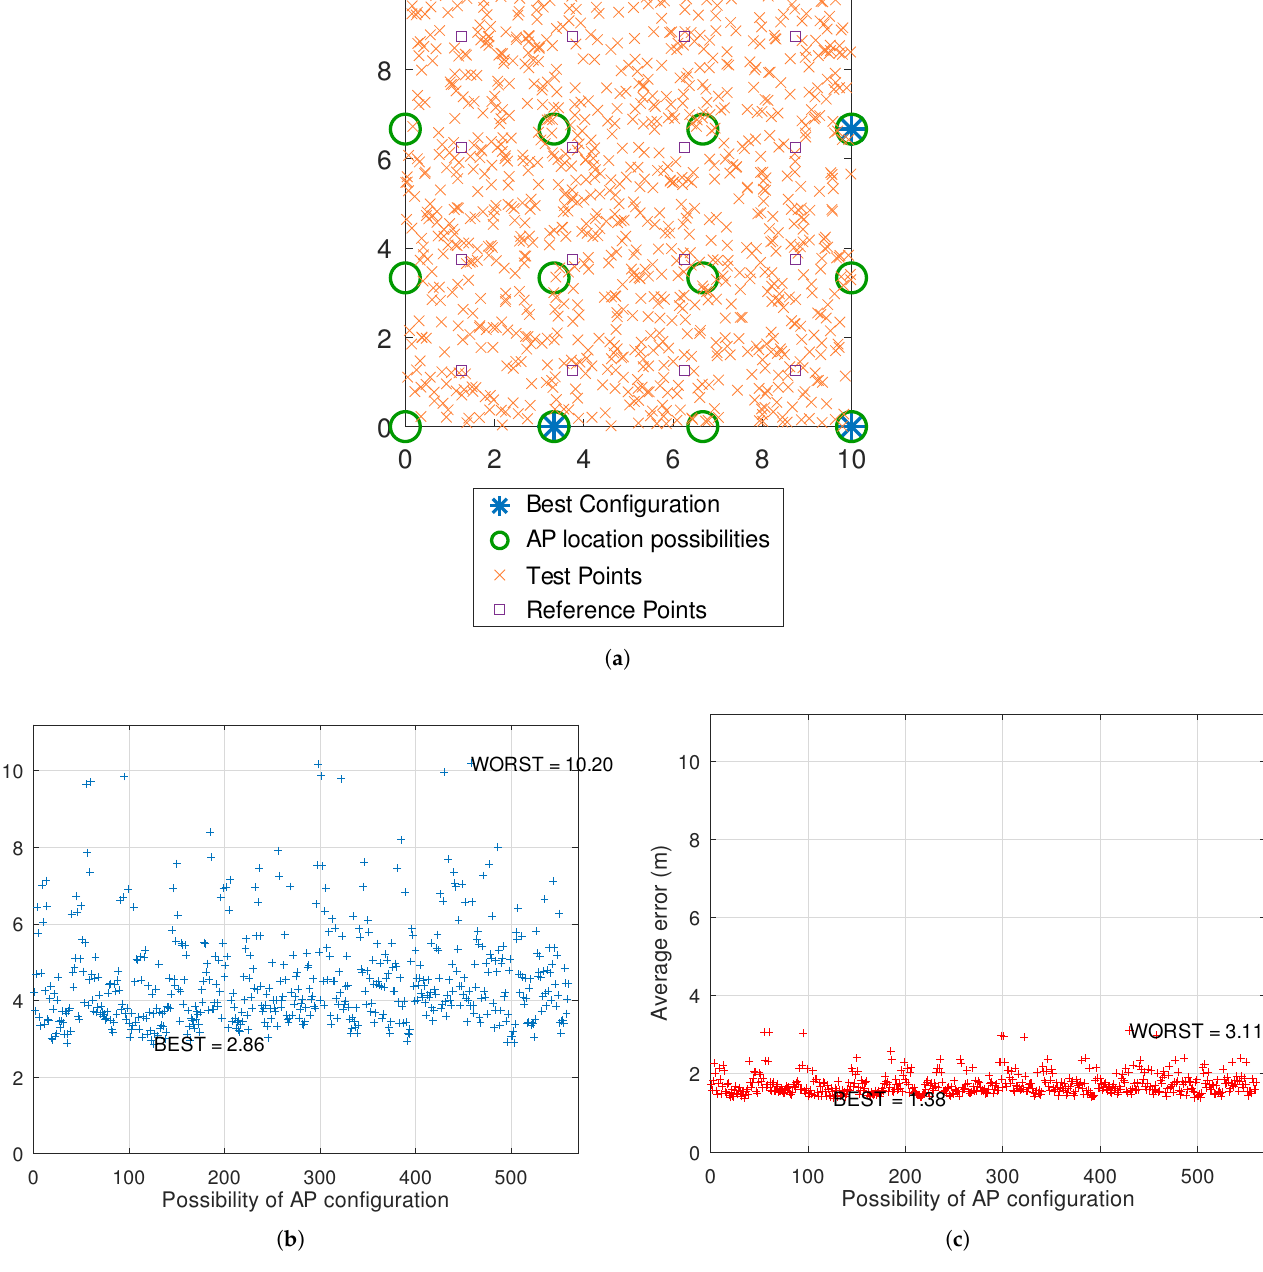
Figure 8. Simulation results in a scenario with 3 APs, 16 RPs and 10 samples per test: ( a ) Configuration with minimum localization error (95%); ( b ) Results of 560 possible AP placements (95%); ( c ) Results of 560 possible AP placements